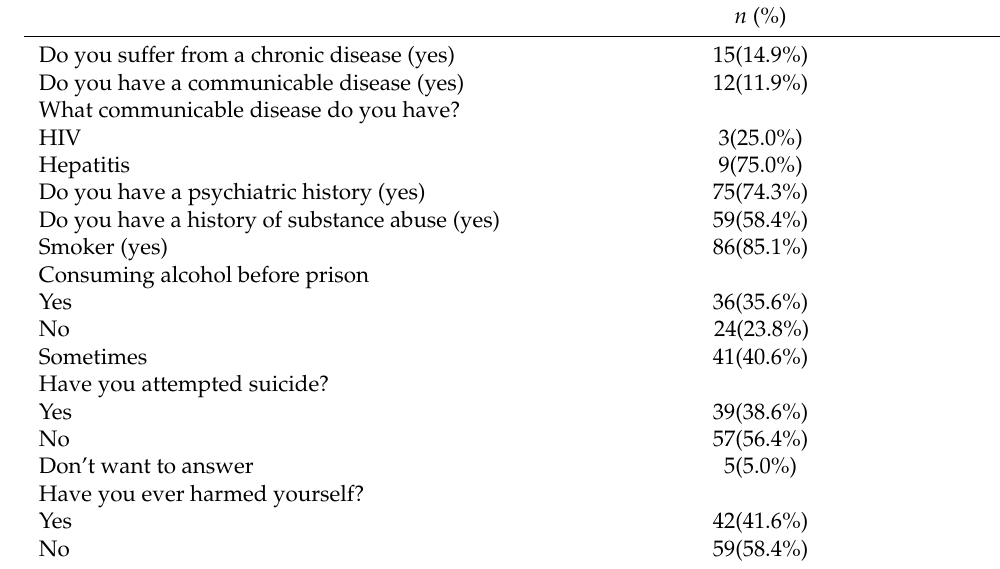
Table 3. Distribution of the sample according to clinical characteristics ( n =